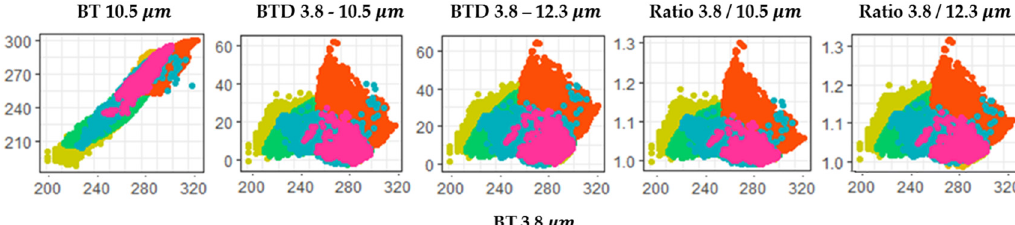
Figure 3. Scatter plot of the brightness temperature (BT) at 3.8 and 10.5 µ m, BT difference (BTD) between 3.8–10.5 and 3.8–12.3 µ m, and ratio of the BT at 3.8/10.5 and 3.8/12.3 µ m for six volcanoes in 2020 (Taal (yellow), Merapi (orange), Merapi_v2 (orange red), Krakatau (sky blue), Semeru (green), and Nishinoshima (deep pink)).